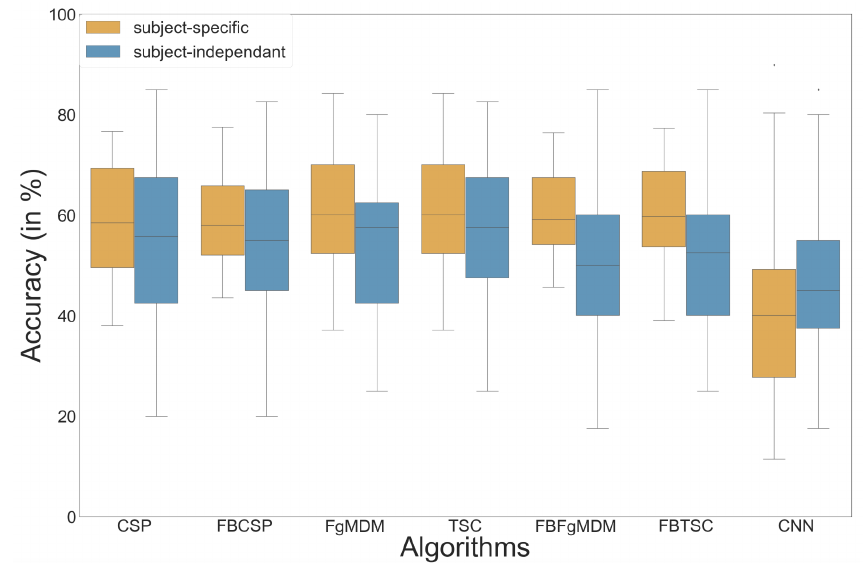
Figure 10. Classification accuracy of each algorithm on the arousal data, in both subject-specific and subject-independent